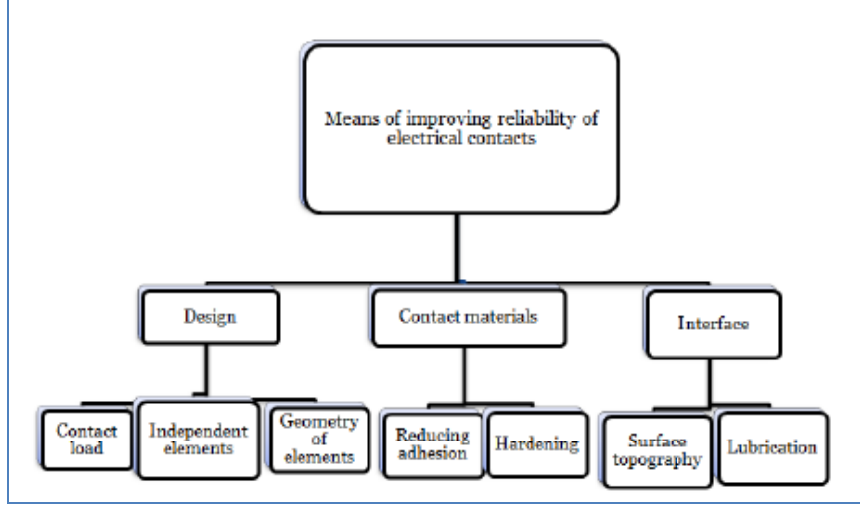
Figure 1: Factors influencing reliability of a connector